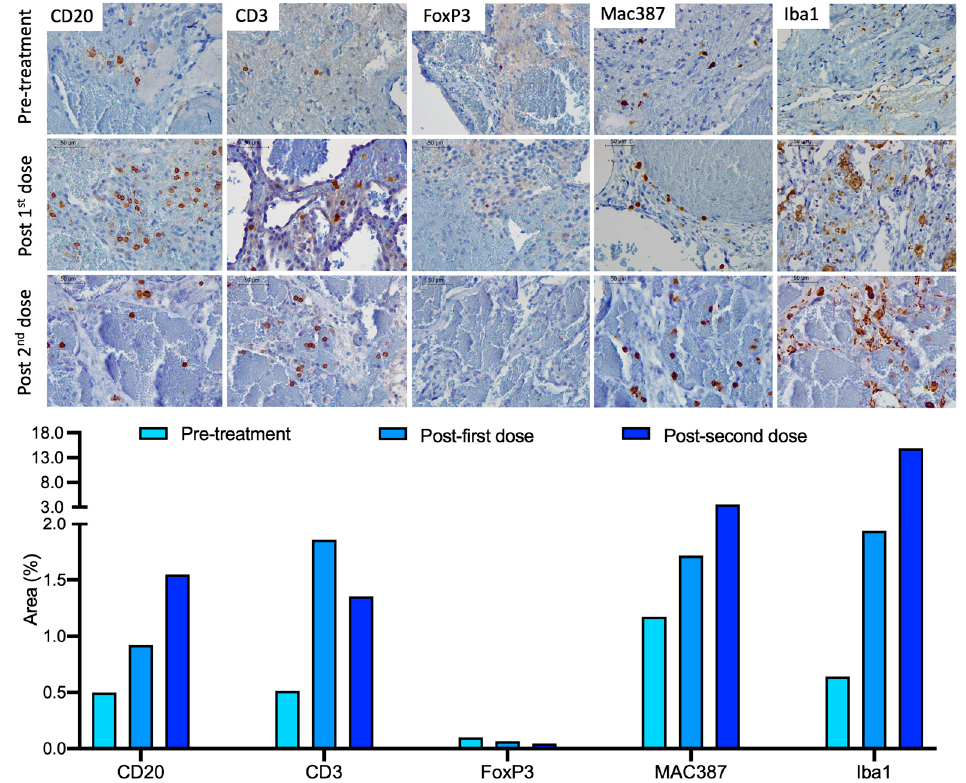
Figure 4. Infiltrated immune cells in the tumor. Tumor tissue pre-treatment (obtained during the first craniotomy), post-first dose (obtained during the second craniotomy) and post-second dose (obtained during necropsy) (top to bottom in each row) were evaluated for the infiltration of B cells (CD20+), T cells (CD3+), regulatory T cells (FoxP3+), M1 macrophages (Mac387+) and activated microglia/macrophages (Iba1+). Scale bar: 50 μ m. The graphic representation shows the area (%) of the positive cells (brown) for each marker.